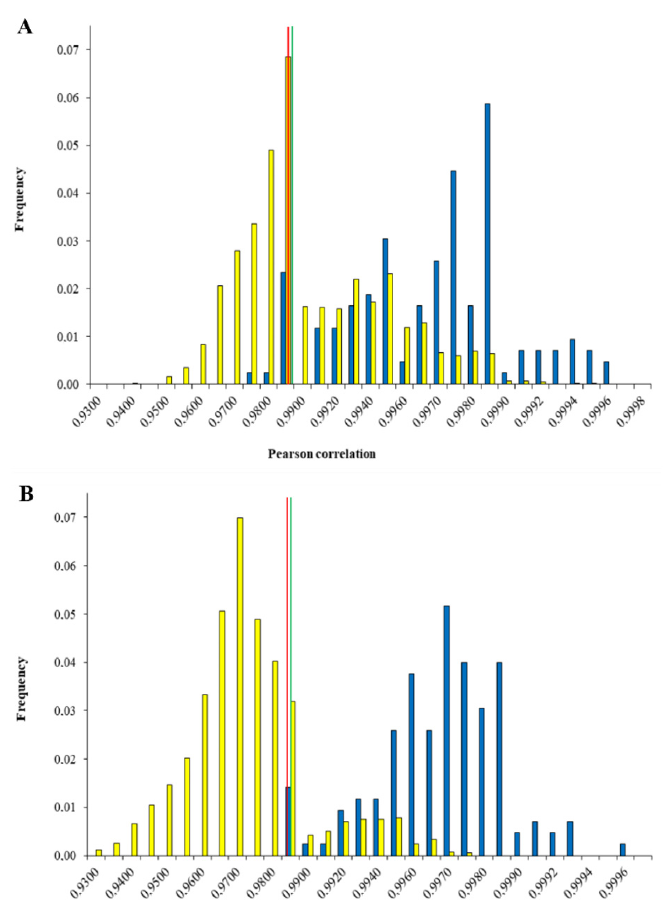
Figure 3. Histograms of the Pearson correlation coefficients and their respective distribution overlap for ( A ) the reference data (GC–FID-aligned data) and ( B ) after fourth root normalization. The yellow bar chart corresponds to the coefficients of the inter-location samples, while the blue bar chart refers to the intra-location correlation coefficients. The two confidence limits are represented as the green vertical line for the 95% CL and the red vertical line for the 99% CL.